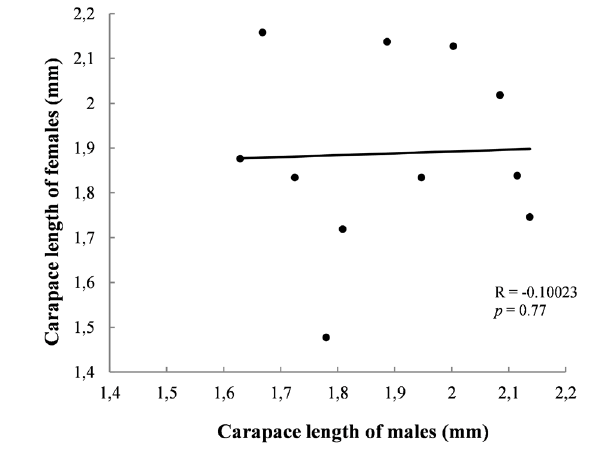
Figure 4. Correlation between the carapace lengths of heterosexual pairs of sponge-dwelling shrimp Typton carneus Holthuis, 1951 from Pontas de Pedras, Pernambuco, northeastern Brazil, sampled between September 2014 and February